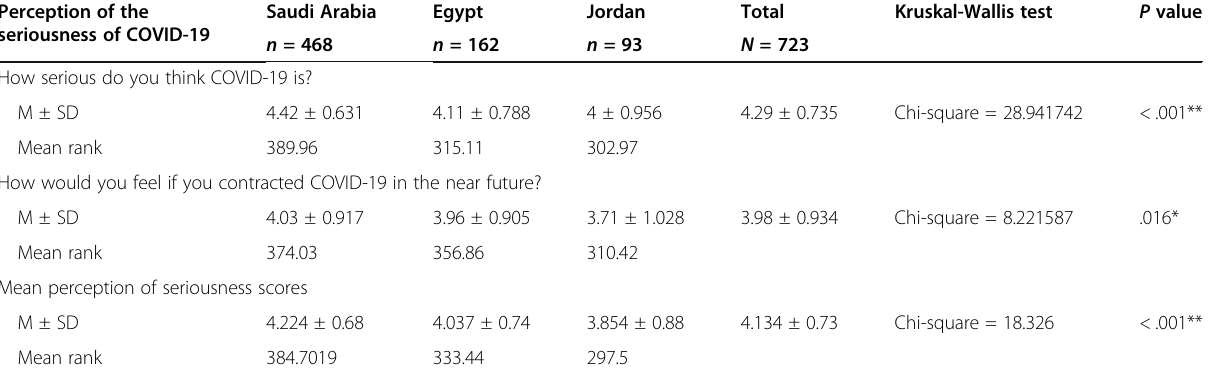
Table 4 Difference in mean “ perception of the seriousness of COVID-19 ” scores, based on the country of origin Perception of the Saudi Arabia Egypt Jordan Total Kruskal-Wallis seriousness of COVID-19